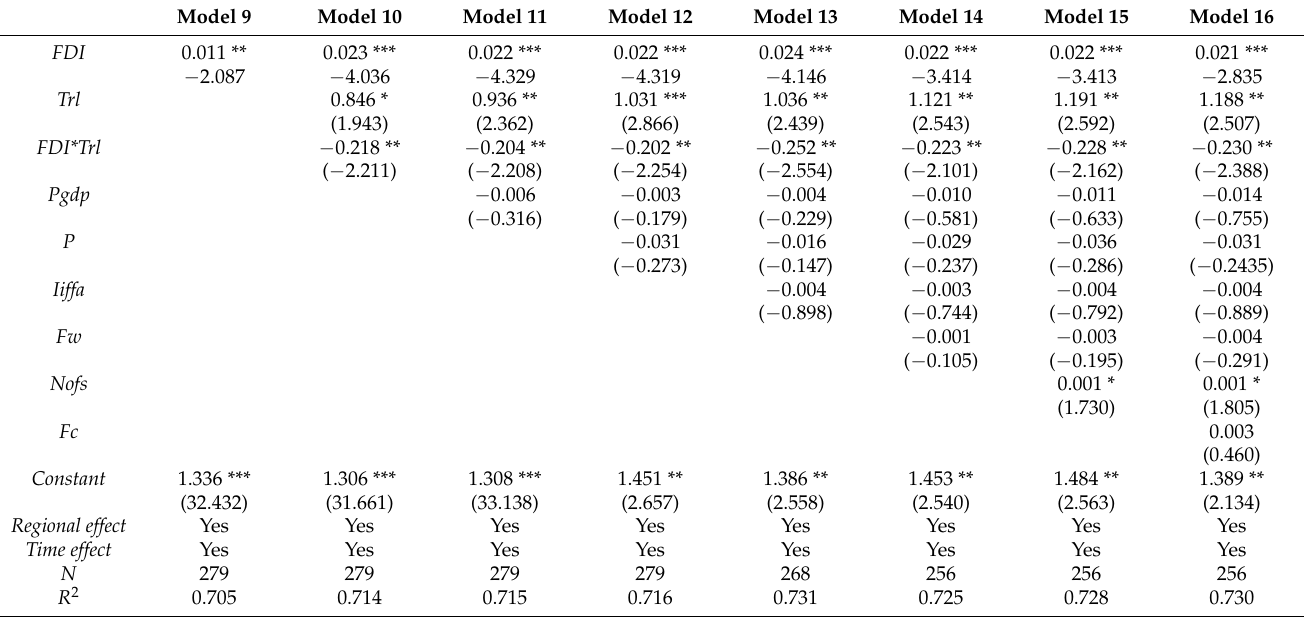
Table 7. Estimated results of the moderating effect of FDI in forestry and labor migration on forestry industry structure